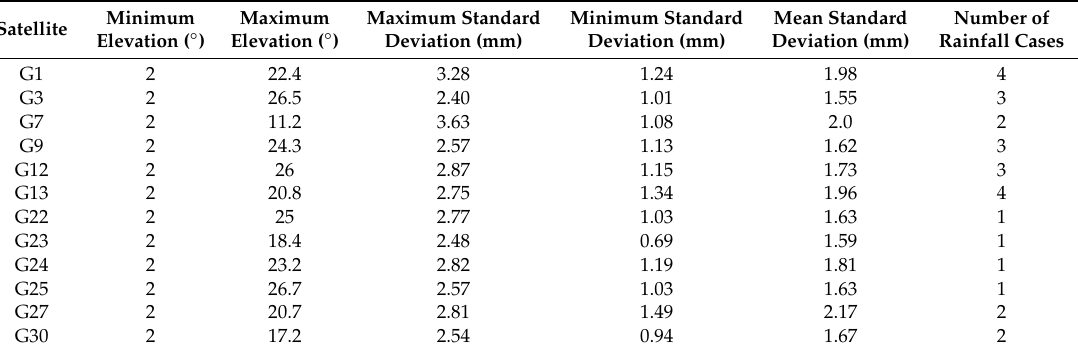
Table 1. Statistical results of different GPS satellites.